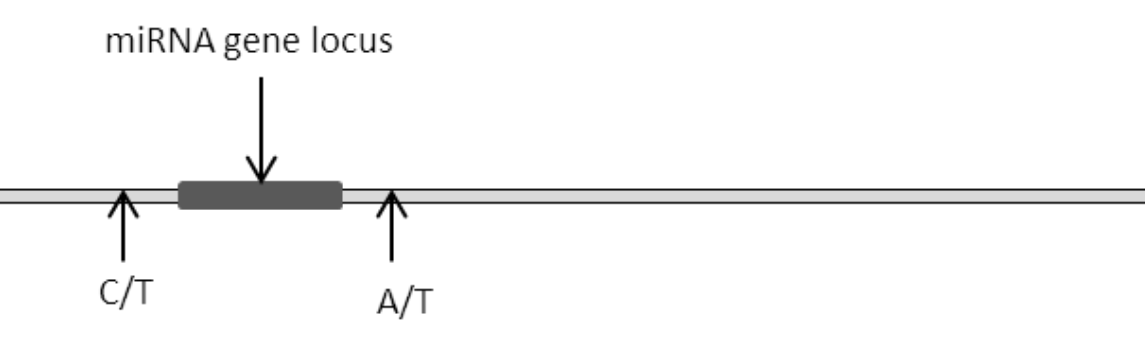
Figure 2. Single base disposition at miRNA